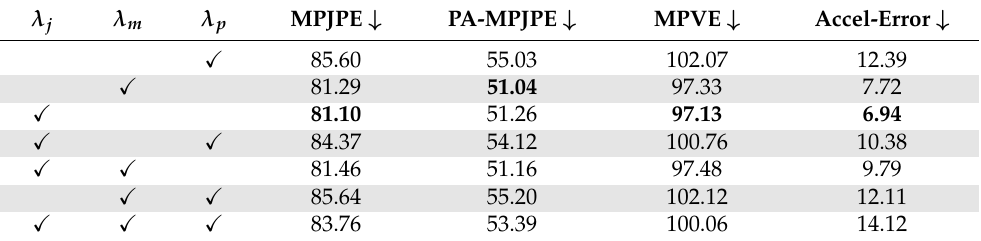
Table 2. Performance comparison of HPR-Net according to various combinations of loss functions. ( (cid:88) = 1.0, blank = 0.0). Bold values indicate best